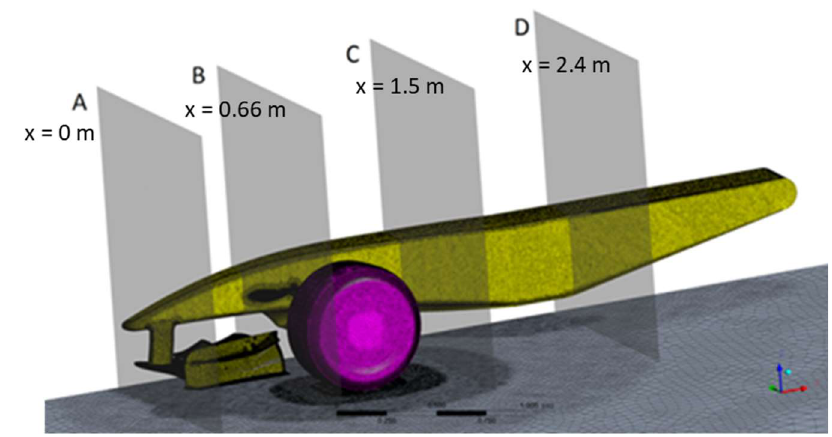
Figure 9. Control planes for the post-processing.